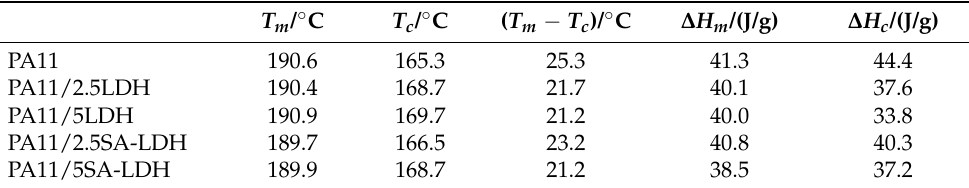
Table 4. DSC data for PA11 and its composites.